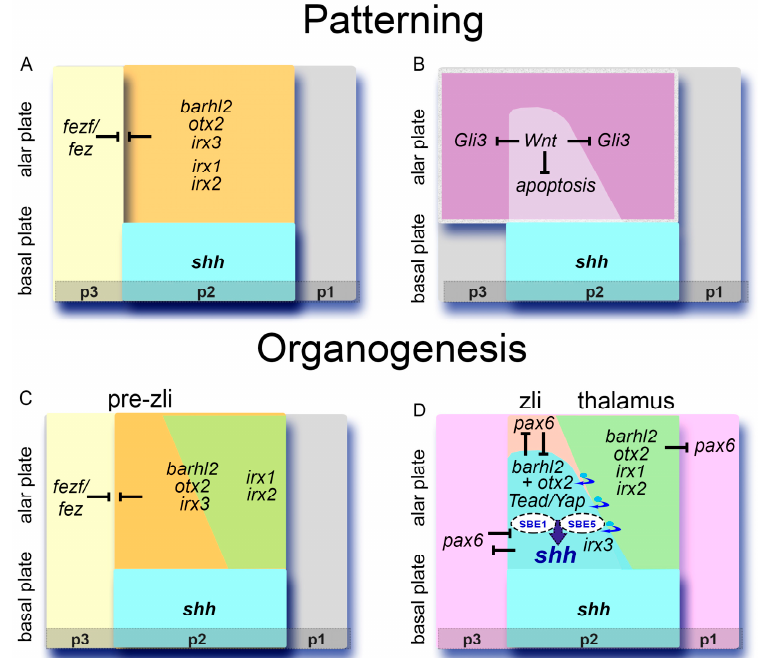
Figure 2. A model for zli formation. ( A ) During neural plate patterning the diencephalic primordium expresses otx2, barhl2 and irx1, irx2, irx3 (orange). Cross-repressive interactions between Fezf/Fez and Irx homeoproteins contribute to formation of the p2/p3 alar border. shh (light blue) is expressed in the p2 basal plate. ( B ) Concomitantly, a Wnt-mediated signal promotes survival of zli anlage cells, and gli3 expression is repressed through a Wnt-mediated signal in a narrow band of cells that correspond to the zli primordium. ( C ) At the onset of zli formation a permissive environment is established in the future zli, and zli cells acquire the competence to express shh . The zli anlage is characterized by the expression of barhl2, otx2, irx3 (orange), and the future thalamus by the expression of barhl2, otx2, irx1/2/3 (green). At the onset of zli development, irx3 is expressed in the future thalamus territory. ( D ) Using a sequential induction mechanism, Shh secreted by the basal plate initiates the spreading of shh expression into the pre- zli domain. Transcription factors (TFs) including Otx1, Otx2, Barhl2, Yap–Tead, and possibly unidentified TFs (TF-X) are recruited to the enhancers SBE1 and SBE5 to initiate shh transcription within the zli . Under the inductive influence of secreted N-Shh, some irx3- expressing cells located in caudal p2 sort out from thalamic cells. Shh signaling from the zli induces the repression of pax6 within the mid-diencephalic furrow. Pax6 together with unidentified dorsal signals could in turn prevent Shh from being expressed beyond the zli . The thalamus (p2) and the prethalamus (p3) receive a combination of Shh signals coming from two orthogonally oriented signaling centers, the zli and the basal plate. Together, they establish a morphogenetic gradient of Shh protein that patterns the thalamus posterior to the zli and the prethalamus anterior to the zli . p: prosomere; zli : zona limitans intrathalamica .